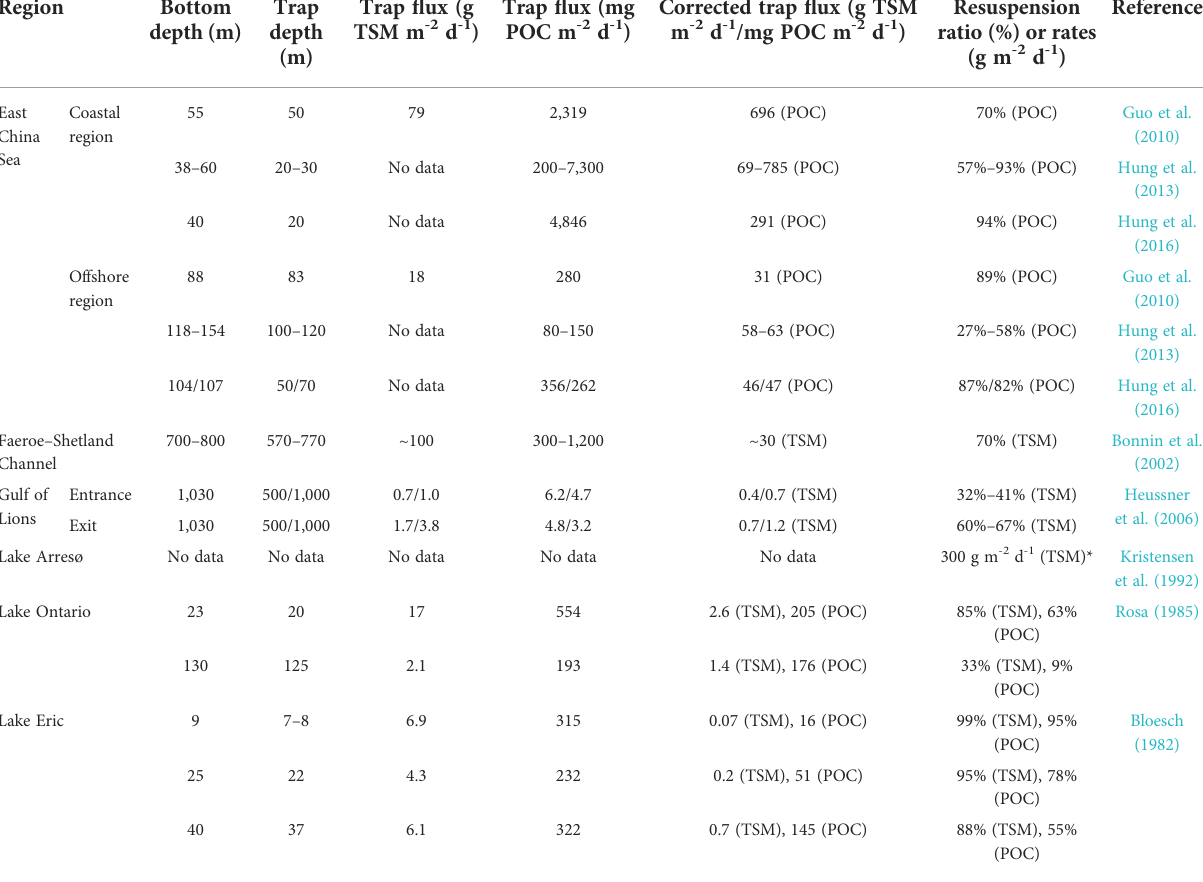
TABLE 3 Literature trap fl uxes and resuspension ratios estimated by total suspended matter (TSM) or particulate organic carbon (POC) data in different regions. Region